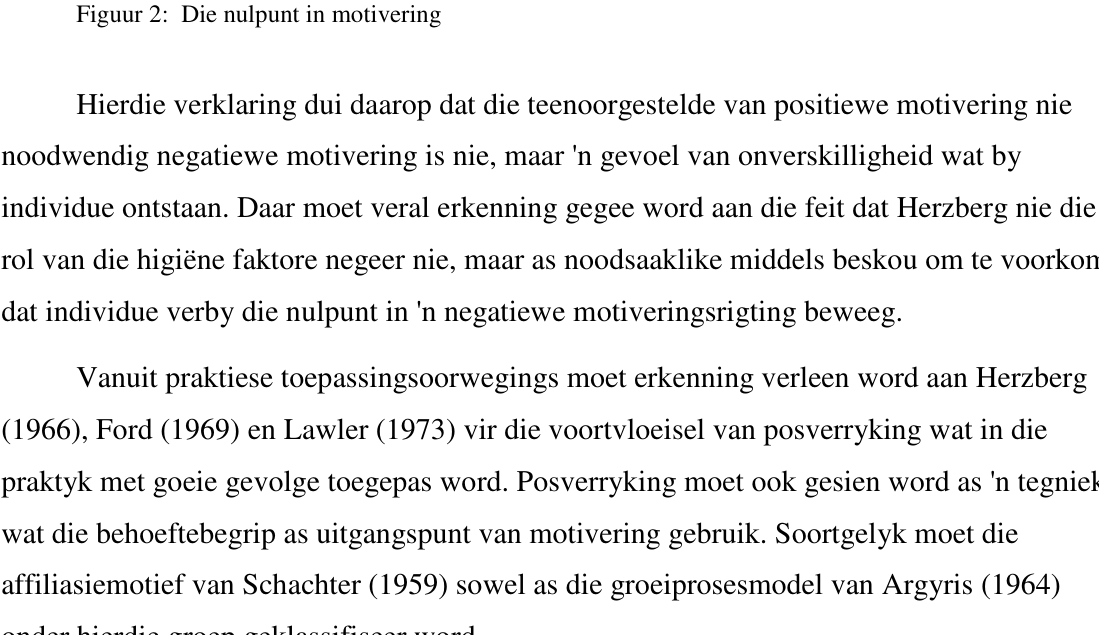
Figuur 2: Die nulpunt in